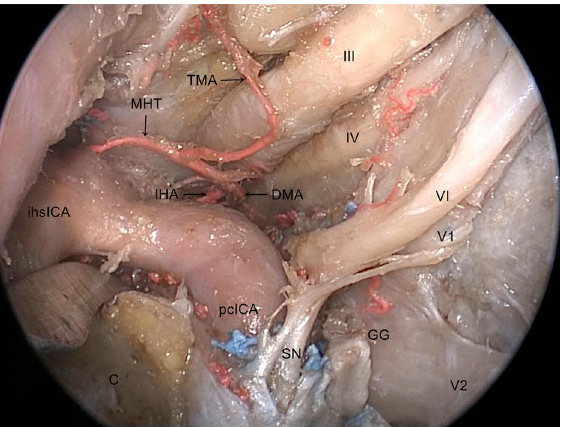
Figure 8. Endoscopic view of the MHT and three branches, the MHT arises from the posterior wall of the ihsICA and then divides into three branches: the inferior hypophyseal artery, dorsal meningeal artery and tentorial marginal artery. pcICA paraclival segment of the ICA, ihsICA inferior horizontal segments of the ICA, C clivus, III oculomotor nerve, IV trochlear nerve, V1 ophthalmic branch of the trigeminal nerve, V2 maxillary branch of the trigeminal nerve, GG gasserian ganglion, VI abducens nerve, SN sympathetic nerve, MHT meningohypophyseal trunk, IHA inferior hypophyseal artery, DMA dorsal meningeal artery, TMA tentorial marginal